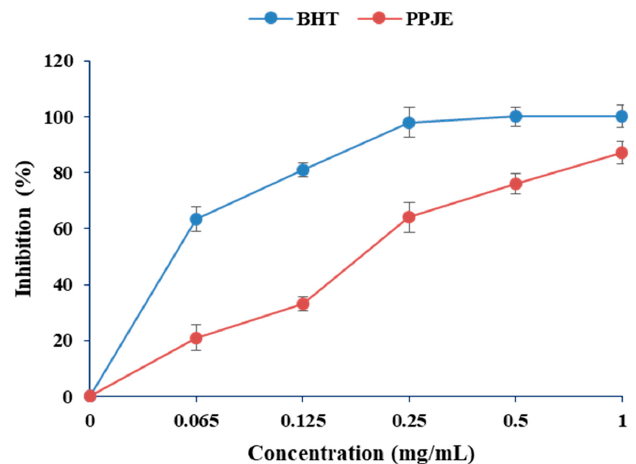
Figure 1. Effects of extracts of O. stricta on in vitro free radicals (DPPH).